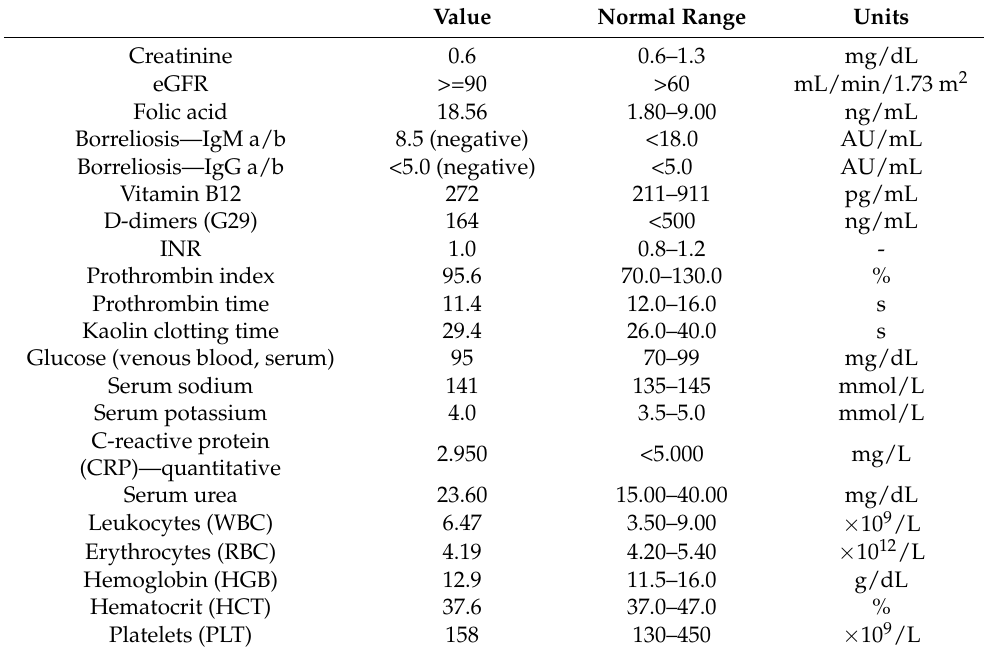
Figure 2. ( a ) T2-weighted (blade) images in sagittal plane; ( b ) DWI b = 1000 axial images; ( c ) cor- responding Apparent Diffusion Coefficient (ADC) map. Well-demarcated, T2 hyperintense lesion (15 × 10 × 15 mm) within splenium of the corpus callosum ( a , b ) with apparent diffusion restriction on DWI/ADC images ( c ). Table 1. Relevant laboratory indices of the